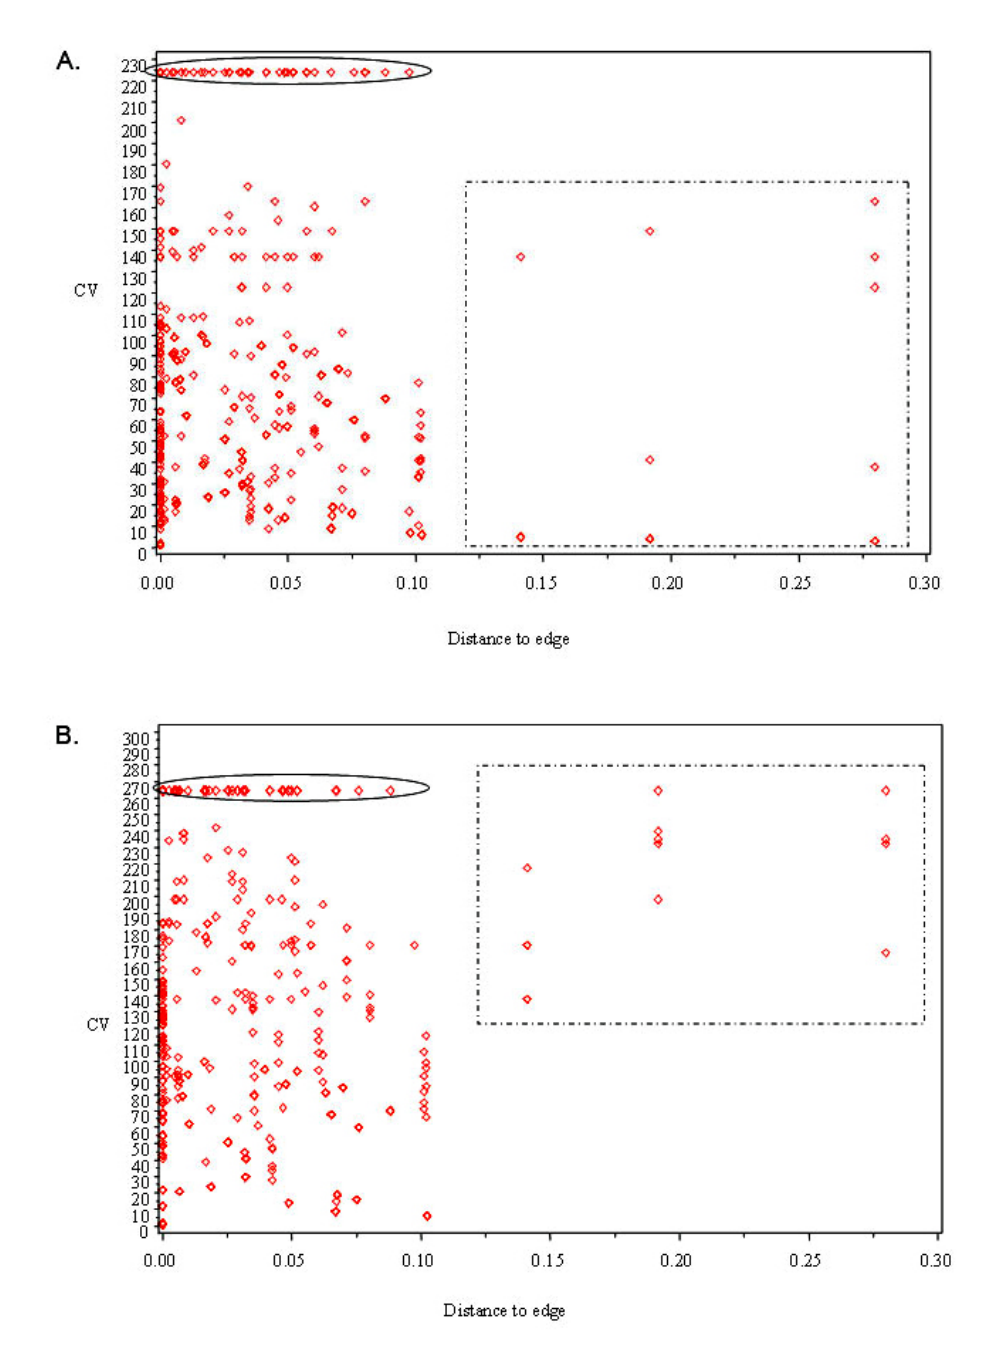
Fig. 4. Plots of coefficient of variation (CV) in relation to distance-to-edge (edge) for temporal analysis (A) and spatial analysis (B) of bird species of the Florida Everglades sub-ecoregion. Each point (diamond) represents one species at one BBS route and their respective CV and edge. Outliers (dashed square) and data removed due to insufficient observations (oval) are